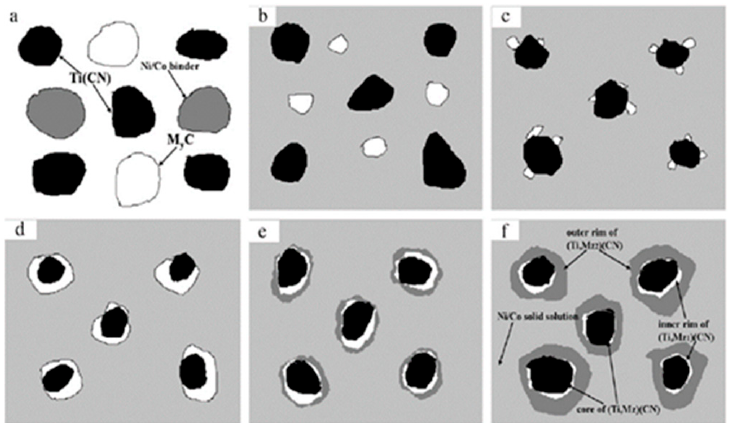
Figure 5. The illustration of structure characteristics in Ti(C,N)–MXC cermets ( a ) 20 °C; ( b ) 950 °C; ( c )1150 °C; ( d ) 1300 °C; ( e ) 1350 °C; ( f ) 1450 °C. Reprinted from Ref. [57] with permission from Int. J. Refract. Metals Hard Mater.